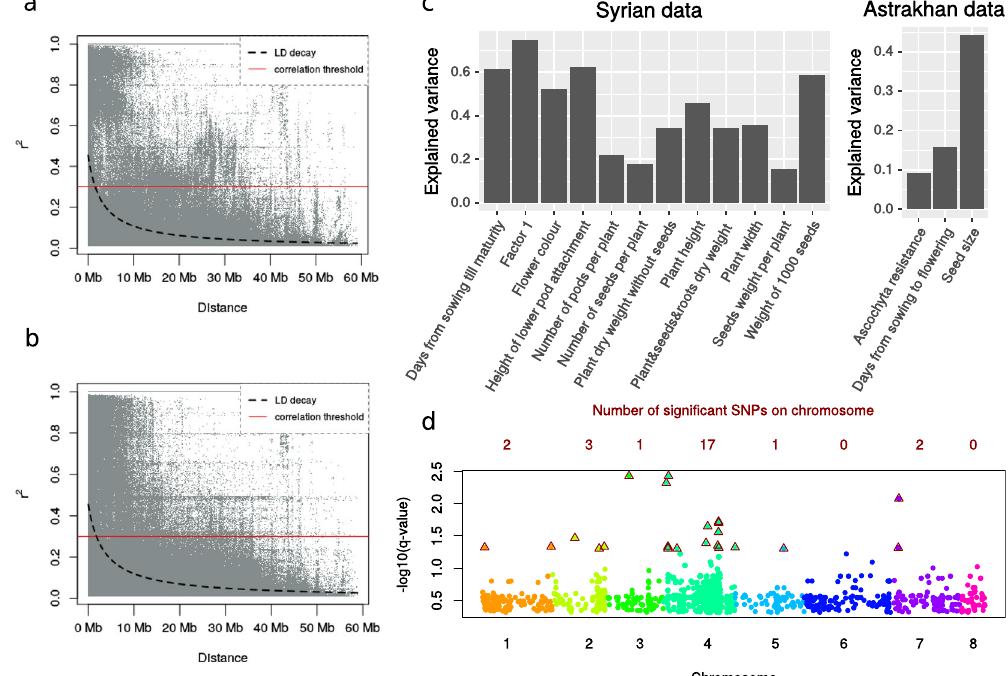
Figure 3. Genomic analyses reveal genetic control of traits and an enrichment of trait associations on chromosome 4 ( a ) LD measured by r 2 as a function of genetic distance between SNPs for all landraces and ( b ) for landraces from Turkey. ( c ) Proportion of phenotypic variance explained by genotype for different traits. y-axis ratio of genetic variance to phenotypic variance of a trait, x-axis – different trait phenotypes. ( d ) Summary of GWAS analyses for Astrakhan (Russia) and Allepo (Syria) phenotype data (different colours corresponds to different chromosomes). SNPs with q-value < 0.05 are shown for each chromosome, marked as triangles. When one position associates with a number of phenotypes with different q-values, only the most significant SNP is